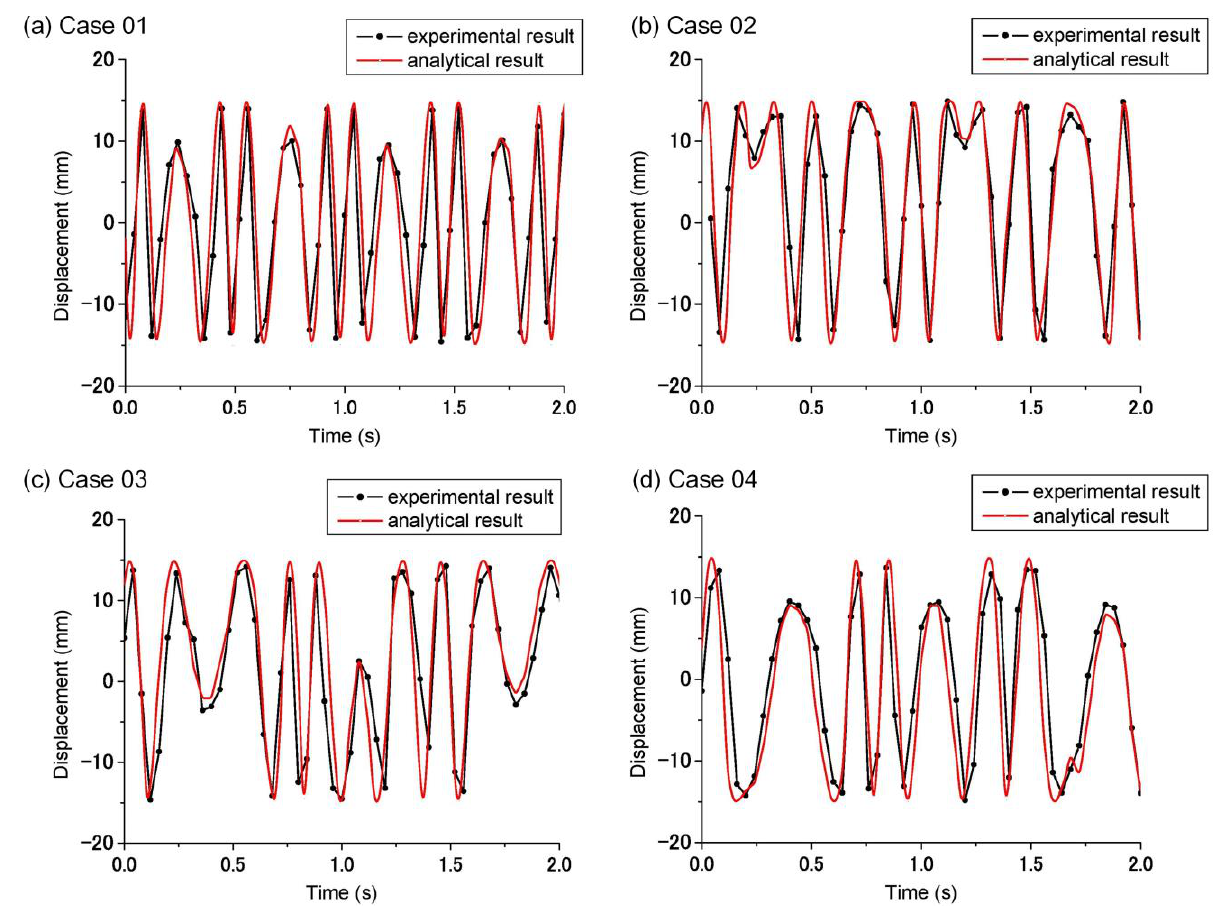
Figure 7. The displacement result of the slider.